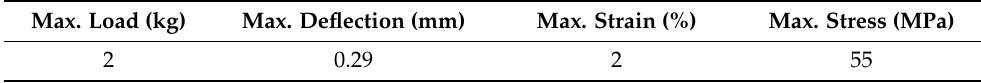
Figure 1. Finite element method (FEM) analysis using ANSYS: ( a ) deformation analysis; ( b ) strain analysis; and ( c ) stress analysis. Table 1. Finite element method (FEM) analysis result.